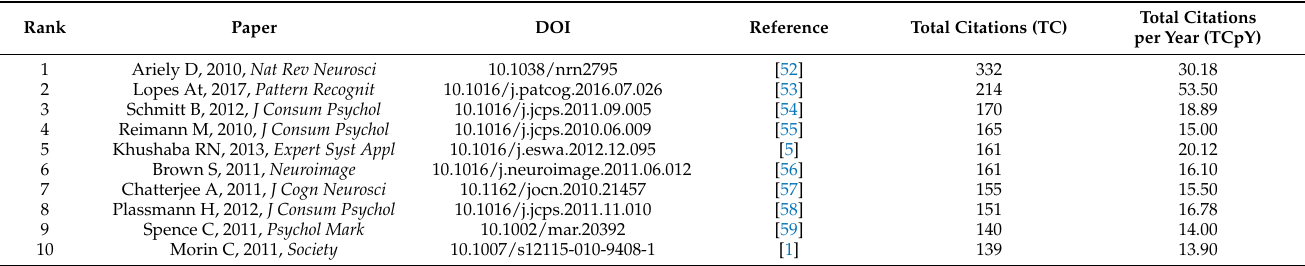
Table 15. Top 10 Most Global Cited